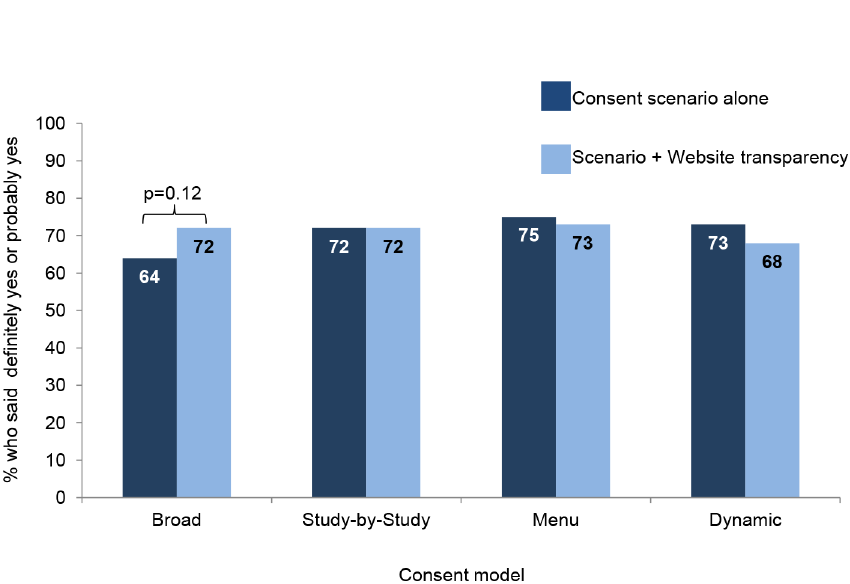
Fig 2. Results of a survey of 2,601 U.S. adults about participation in a nationwide longitudinal study of genes and environment. Willingness to share samples and information under different consent